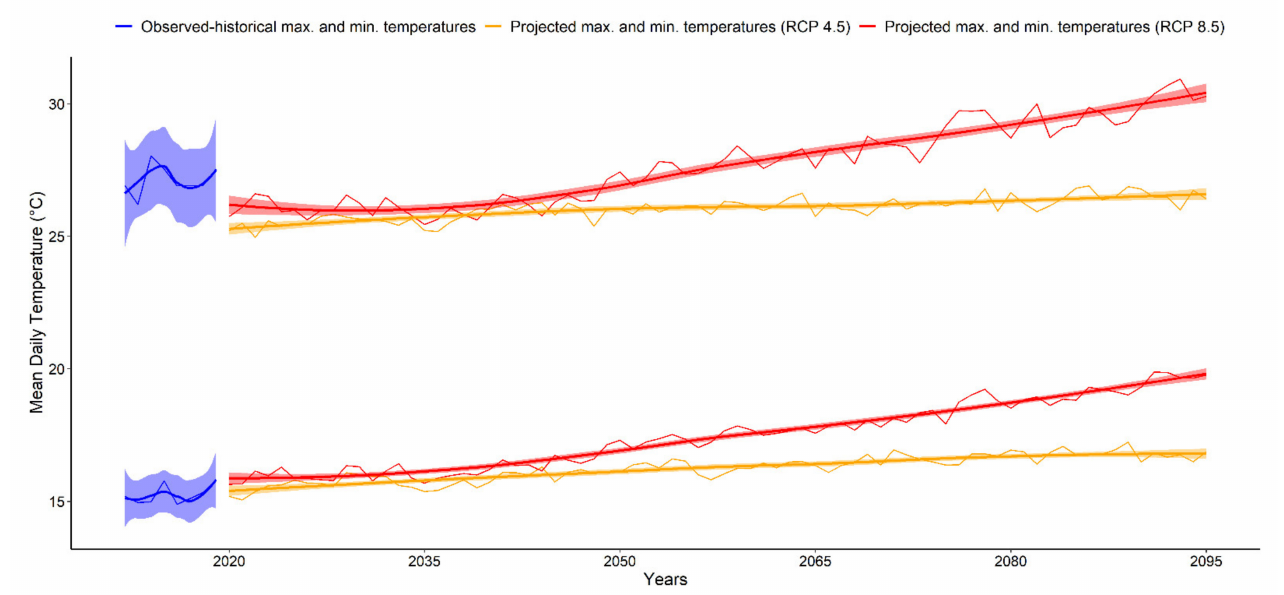
Figure 3. Annual mean precipitation amount for the observed historical climate condition and the two climate change projections corresponding to RCPs 4.5 and 8.5. The shaded area shows the 95% confidence interval enclosing the linear trendline estimated for the temperature data.